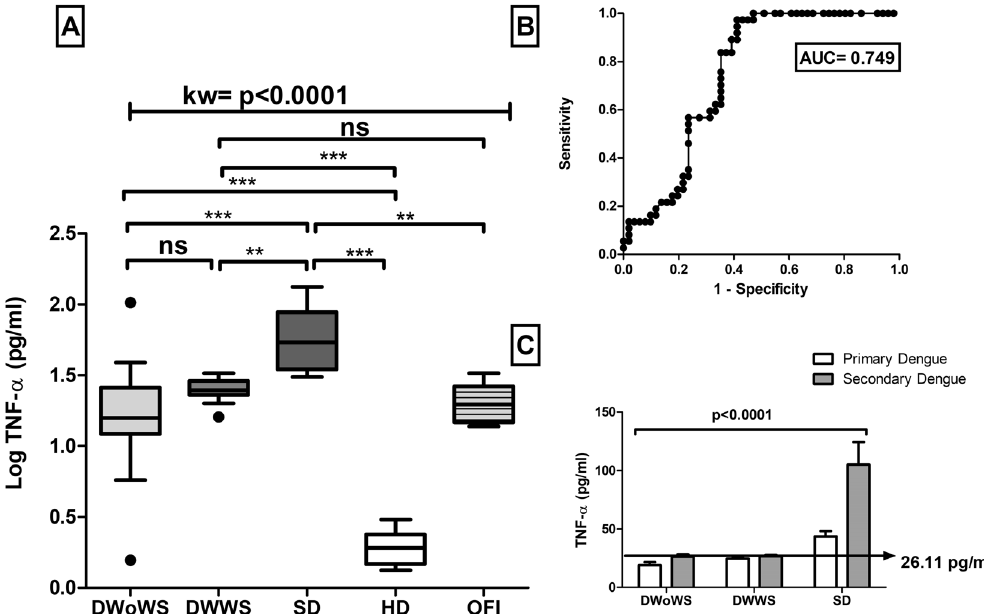
Figure 5. ( A ) Levels of TNF-α of dengue without warning sign (DWoWS), dengue with warning signs (DWWS), severe dengue (SD) and Other febrile infection (OFI). Study subjects are significantly different from each category. ( B ) Receiver operating characteristics curve analysis obtained the AUC = 0.749. ( C ) Levels of TNF-α of primary and secondary dengue infection. Arrow line showing the severity cut ‐ off value (26.11 pg/mL) obtained from the Youden index. Study subjects are significantly different from each category is indicated by P < 0.05. AUC, area under the curve; HD, healthy donors. Statistical analysis was performed using the